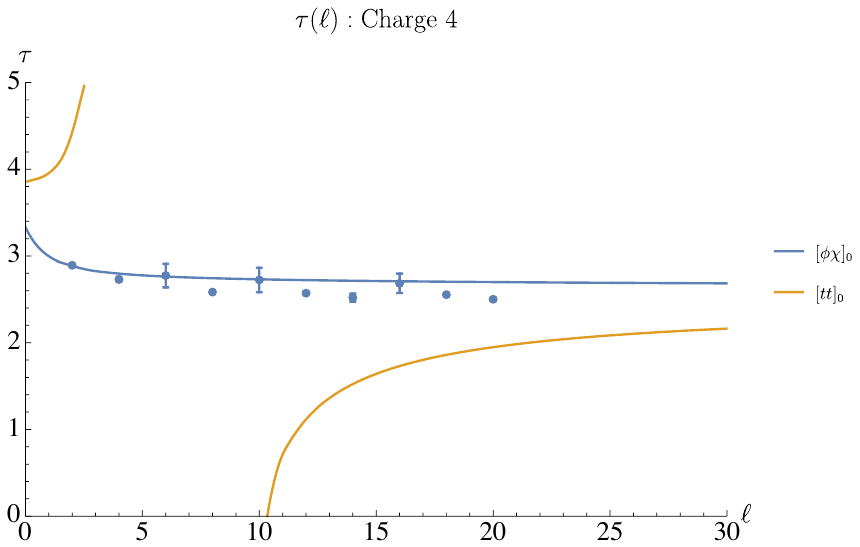
Figure 13 . Analytic predictions for charge 4 even spin anomalous dimensions, and their compar- ison with numerics. In order of increasing spins, the combined numerical data from 40 extremal spectra contains f 40 ; 40 ; 10 ; 40 ; 14 ; 40 ; 38 ; 17 ; 38 ; 39 g operators around this twist range for spins 2-20. Despite the limited data at some spins we still see decent agreement with the [ (cid:30)(cid:31) ] 0 trajectory.